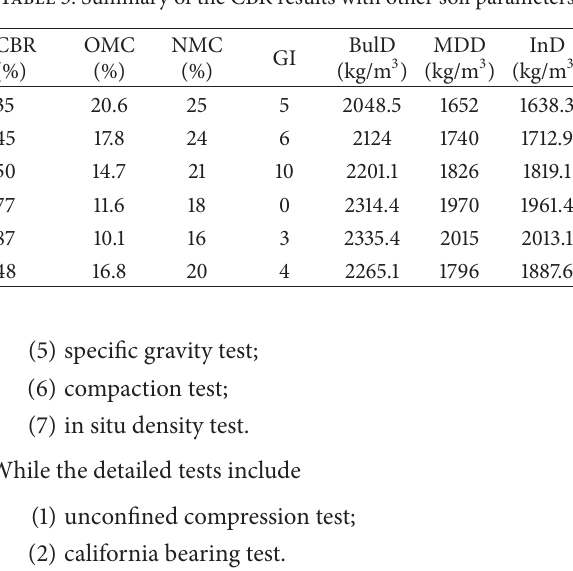
Table 3: Summary of the CBR results with other soil parameters.